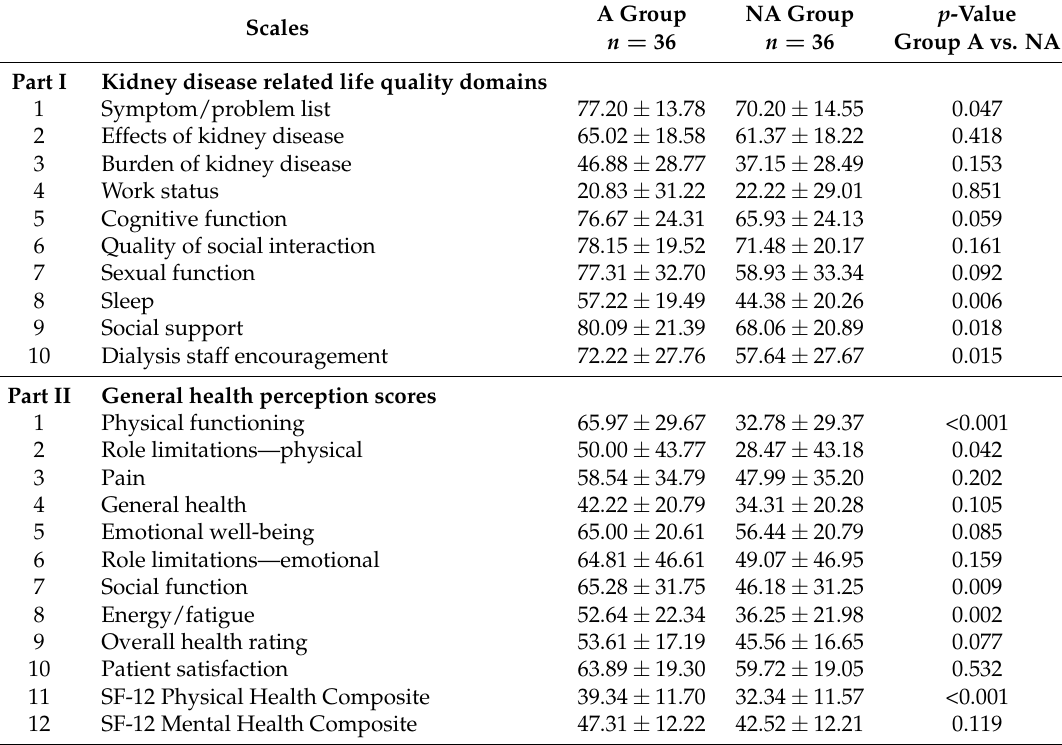
Table 4. Quality of life in relation to adherence to physical activity recommendations. A Group NA Group p -Value Scales n = 36 n = 36 Group A vs. NA Part